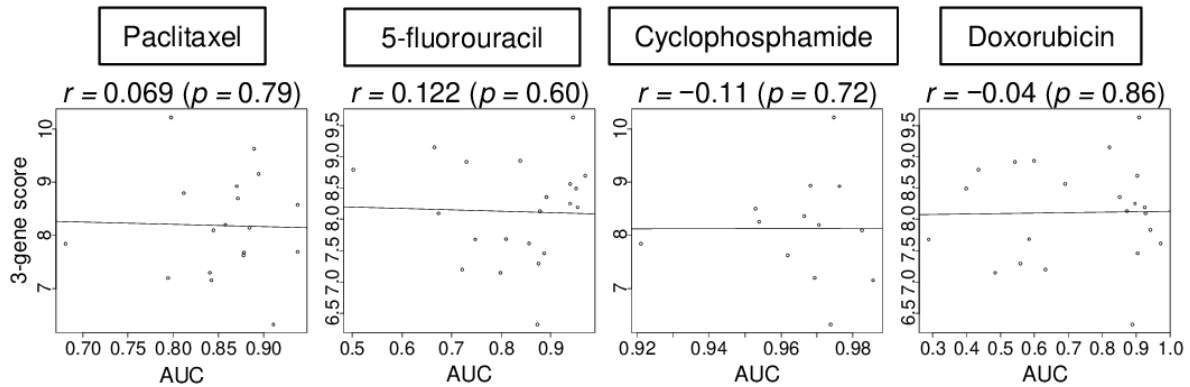
Figure 5. Correlation of the 3-gene score with treatment response in cell lines. Correlation plots between the 3-gene score level and area under the curve (AUC) of several drug sensitivity, paclitaxel, 5-fluorouracil, cyclophosphamide, and doxorubicin, for TNBC cell lines. Spearman rank correlation was used for the analysis.